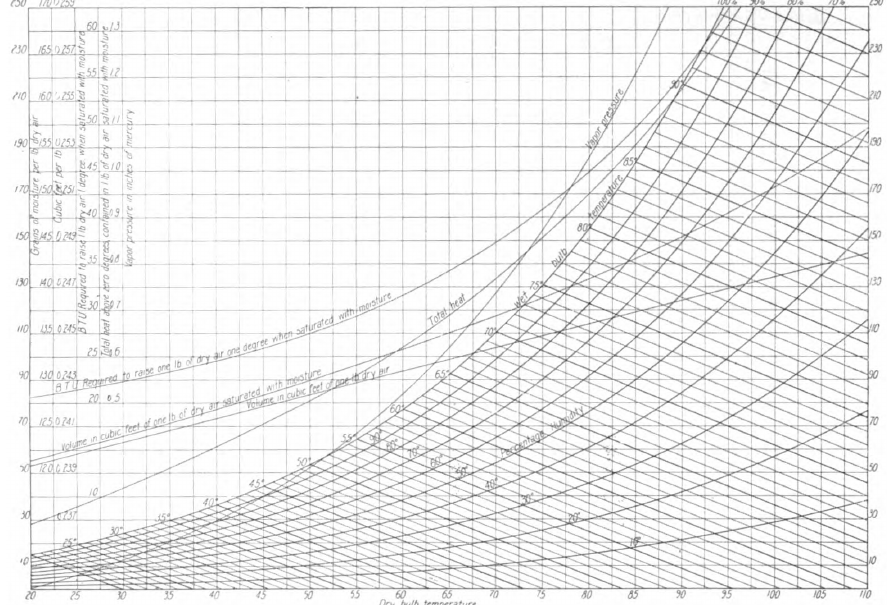
Figure 1. Willis Carrier’s first psychrometric chart [1]. Here, the abscissa is labeled “Dry bulb temperature” and provided in degrees Fahrenheit; the ordinate is “Grains of moisture per lb dry air”. Several other chart formats were presented concurrently for representing vapor liquid equilibria in air. Synthetic air charts were popular during the 1910s [2], and the Bulkeley chart was proposed in 1926 [3] to supersede Carrier’s psychrometric chart as ASHVE’s offi- cial chart. The motion was put in place and seconded by Carrier himself [3], but at this point, his original psychrometric chart had already become ingrained in the comfort